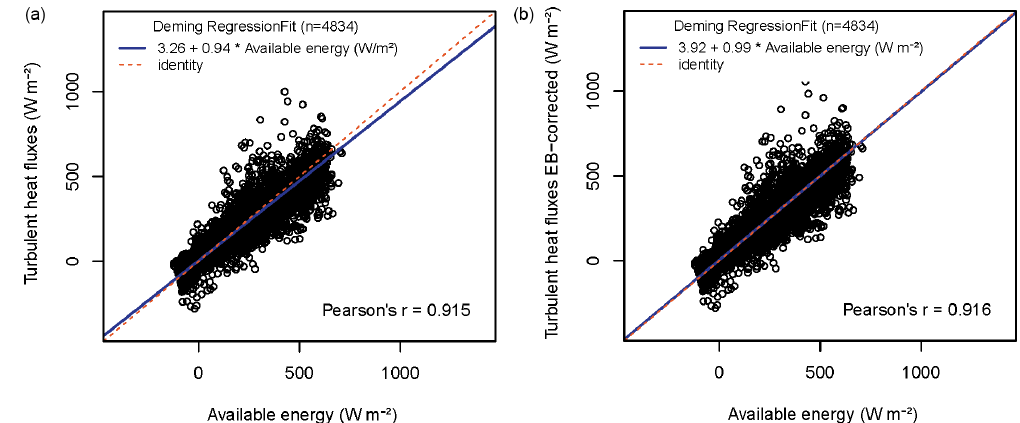
Figure 6. Results of the orthogonal regression analysis of the sum of the turbulent heat fluxes ( H + λE) vs. the available energy ( R n − G ) as measured (a) and after application of the energy balance closure correction (b) for the DK-Sor dataset.